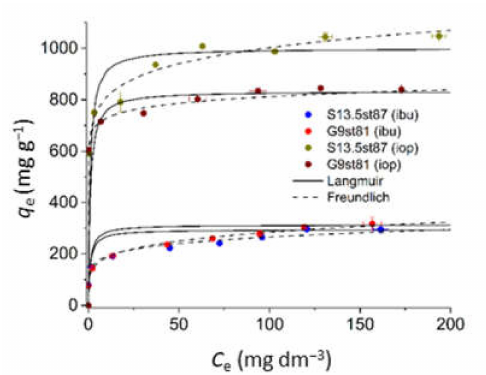
Figure 10. Adsorption isotherms of ibuprofen and iopamidol onto activated carbons